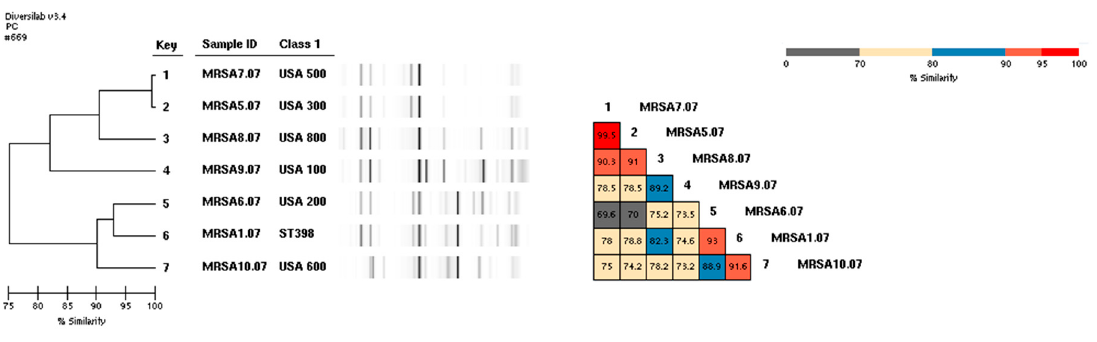
Figure 2. Rep-PCR generated dendrograms for six MRSA reference strains (#1–5, 7) and one MRSA ST-398 (#6). The gel-like image generated by the Diversilab software illustrates band similarities.